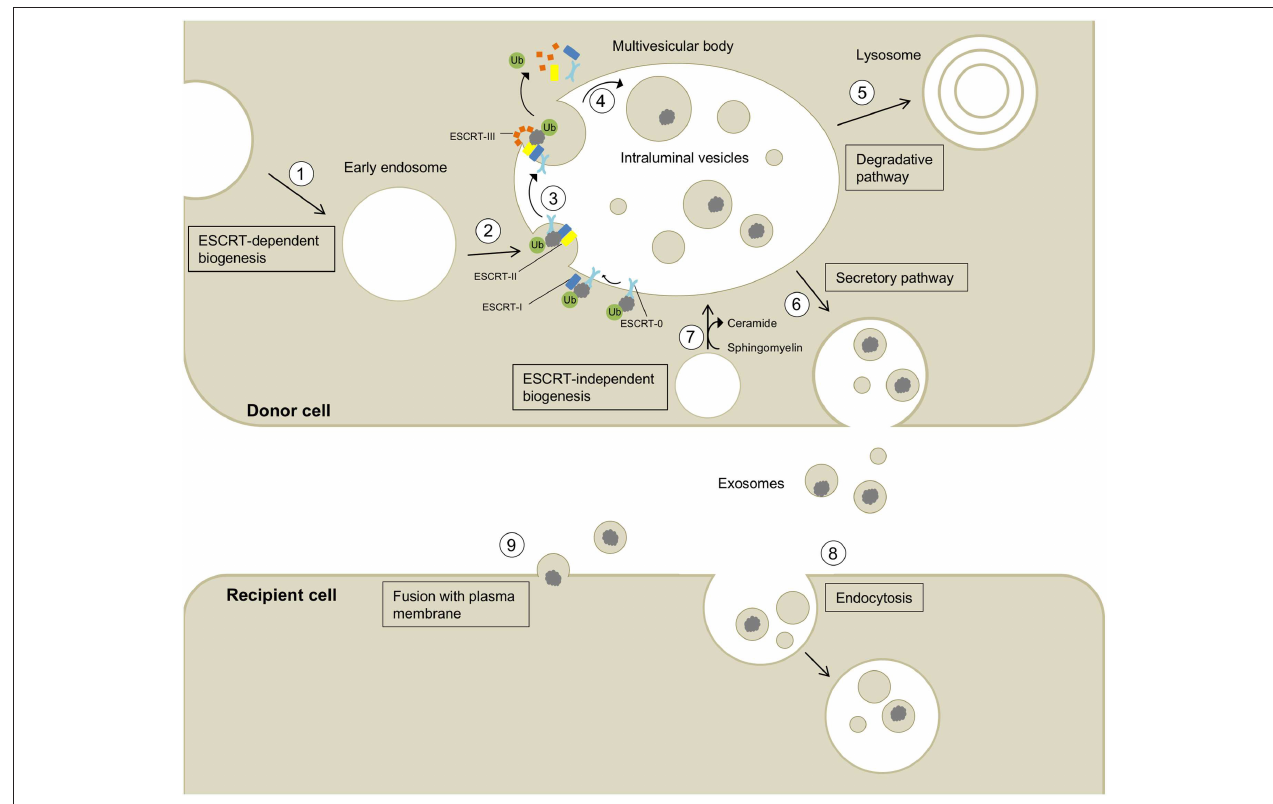
FIGURE 1 | Biogenesis, secretion, and uptake of exosomes and their cargo. (1) Invagination of the cell membrane leads to the formation of early endosomes. (2) ESCRT-0 recognizes and binds ubiquitynated proteins and further recruits ESCRT-I (including the exosomal marker TSG101) and ESCRT-II to this complex. (3) ESCRT-III is a transient protein complex that plugs the inward budding vesicle to avoid the escape of the cargo during scission. Alix recruits deubiquitinases to ESCRT-III, which remove ubiquitin from cargo proteins (Budnik et al., 2016). ESCRT proteins detach from the membrane and are released into the cytoplasm. (4) The formed intralumenal vesicle contains the cargo protein and can either be (5) degraded in lysosomes or (6) secreted into the extracellular space. (7) The formation of intralumenal vesicles can occur via ESCRT-independent pathways and is promoted by higher levels of ceramides in the lipid membrane ( Budnik et al., 2016). Exosomes released into the extracellular space can be taken up by recipient cells by endocytosis (8) or fusion with the plasma membrane (9) allowing the transport of cargo between different cells and body parts.